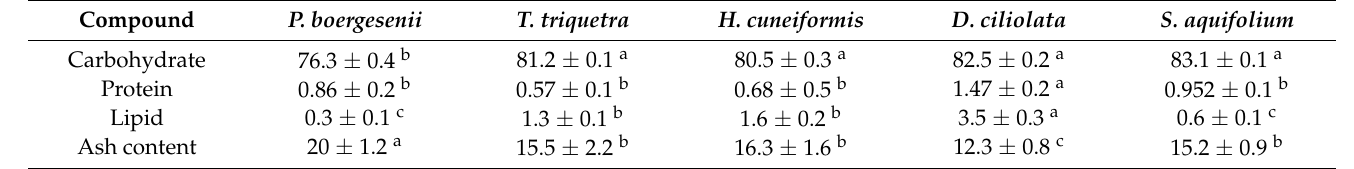
Table 5. Biochemical composition of the extracted sodium